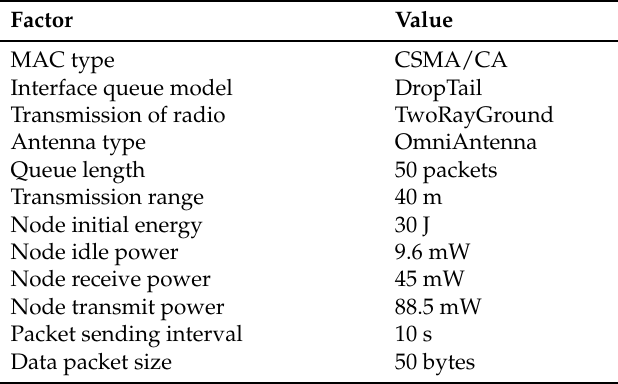
Table 1. Parameters of a sensor node.